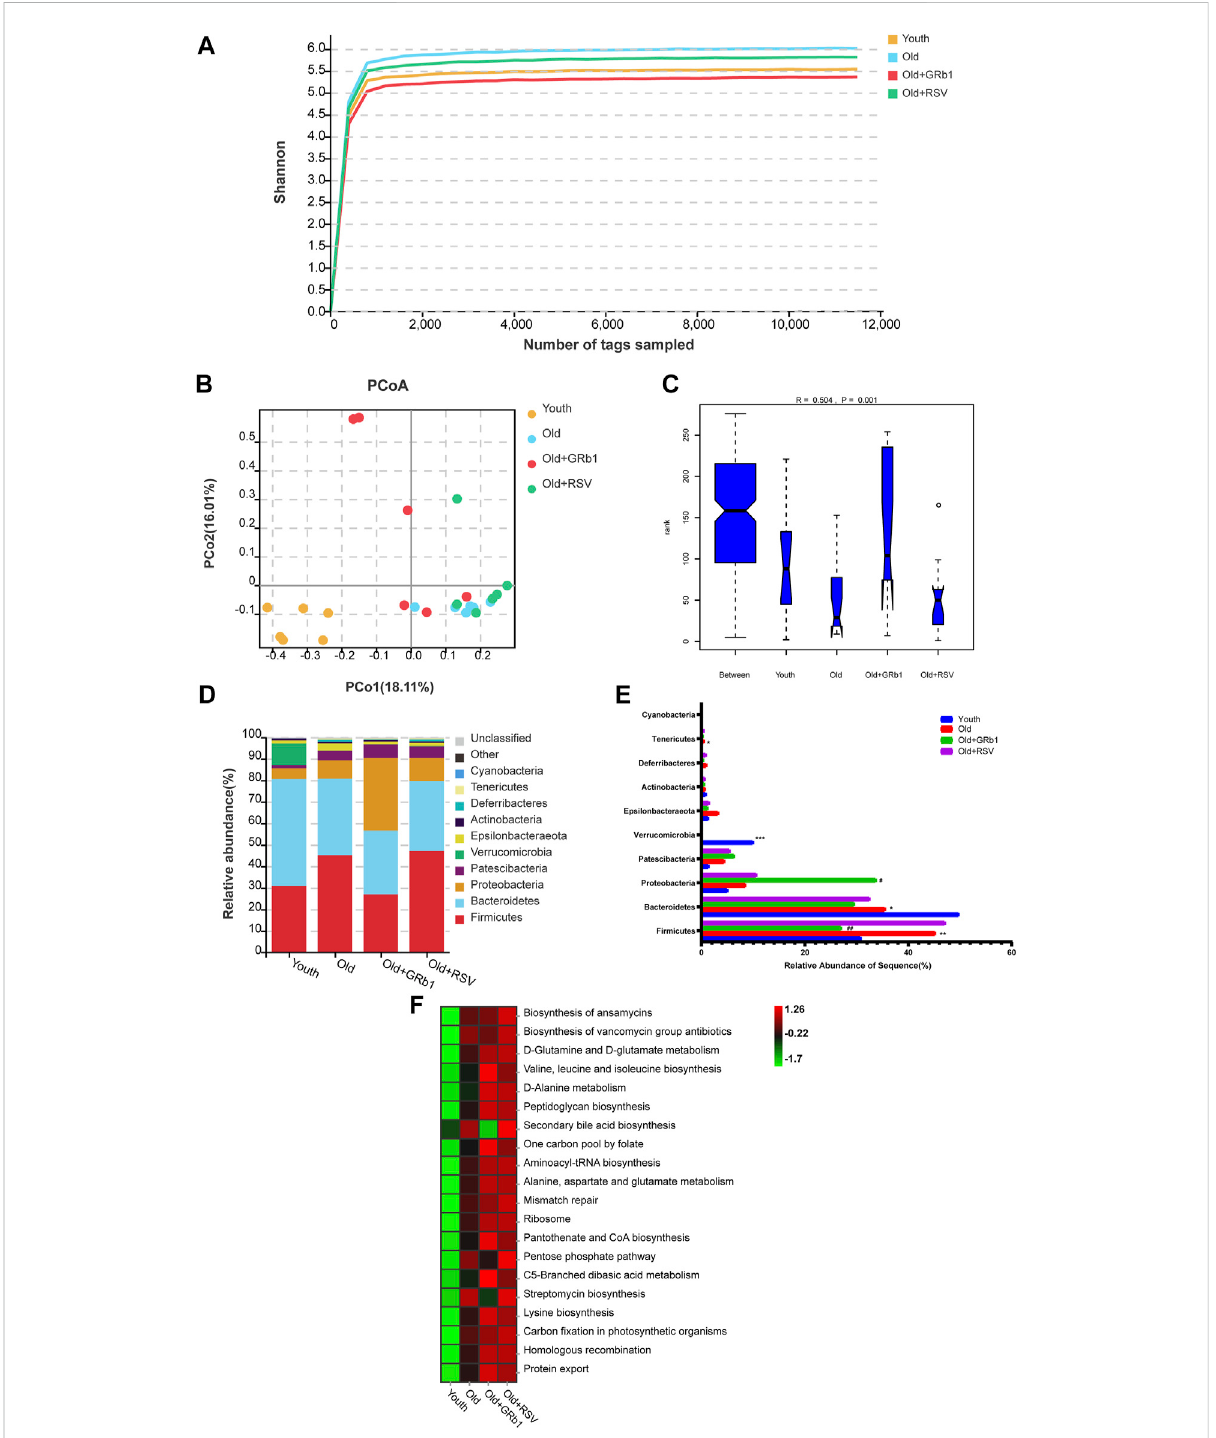
FIGURE 5 GRb1 changed therelativeabundance and functions of gut microbiota of oldmice. (A) Shannon rarefaction curves for each group. (B) The PCo analysisofthegutmicrobiota. (C) Analysisofsimilarity(ANOSIM)ofthegutmicrobiota. (D) Relativeabundanceofthegutmicrobiotaatphylumlevels in mice. Different colors illustrated different fl ora. (E) Bar chart of proportional abundance of the gut microbiota at phylum levels in mice. (F) KEGG analysis showed the top 20 altered pathways of the gut microbiota. * p < 0.05, ** p < 0.01, *** p < 0.001, compared with the Youth group; # p < 0.05, ## p < 0.01, compared with the Old group. PCo, Principle